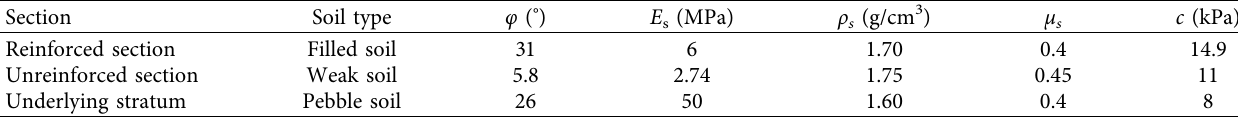
Table 1: Calculating